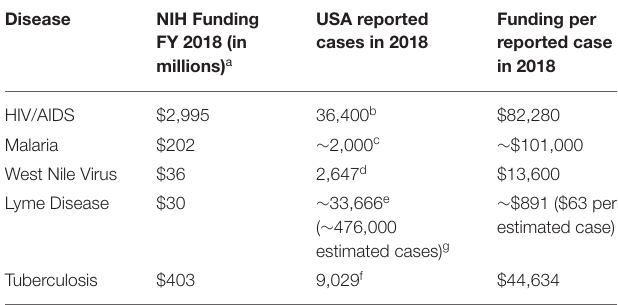
TABLE 1 | NIH support for LD research is currently low compared to other infectious